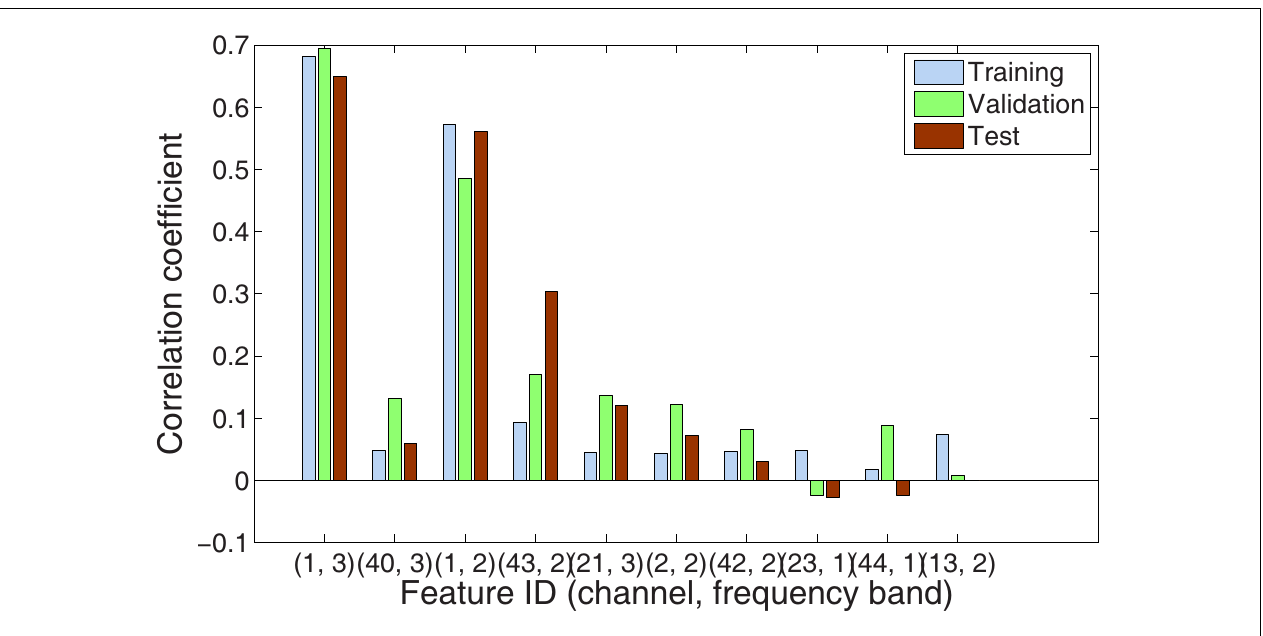
fast gamma band).The Y -axis indicates the correlation coefficients of training, validation, and test set, respectively, regarding each feature individually.